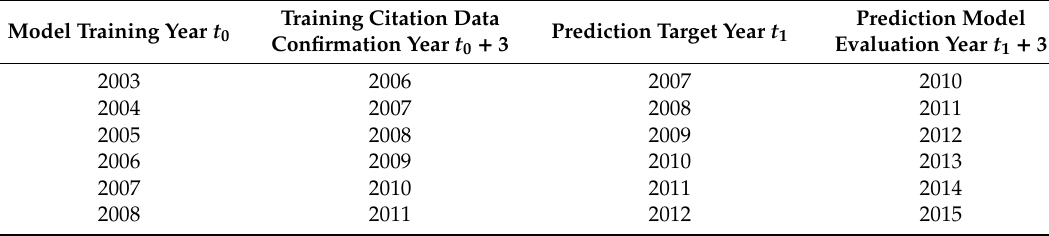
Table 2. Combination of learning and evaluation years for each model.